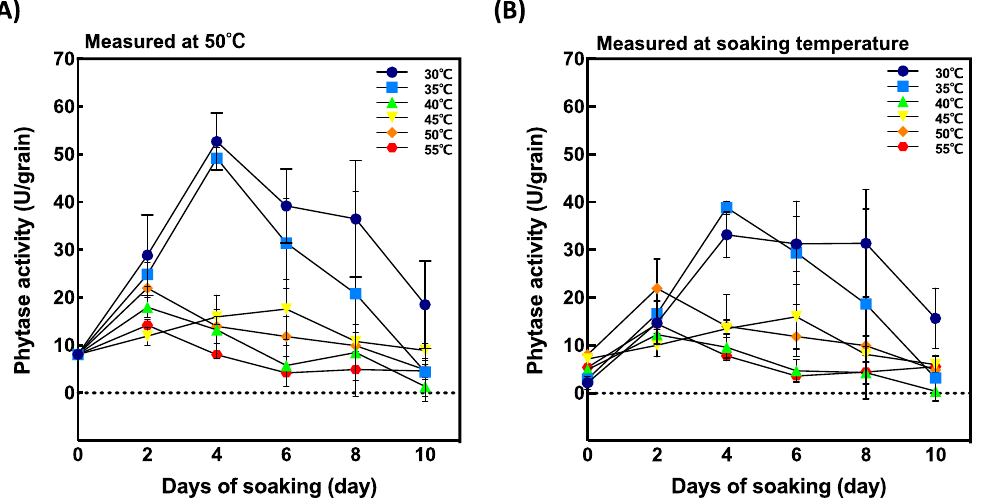
Figure 3. Effect of soaking temperature on phytase activity in germinated brown rice (GBR). ( A ) phytase activity measured at 50 °C and ( B ) phytase activity measured at soaking temperature. Data are shown as the mean ± standard deviation from 3–5 replicates.